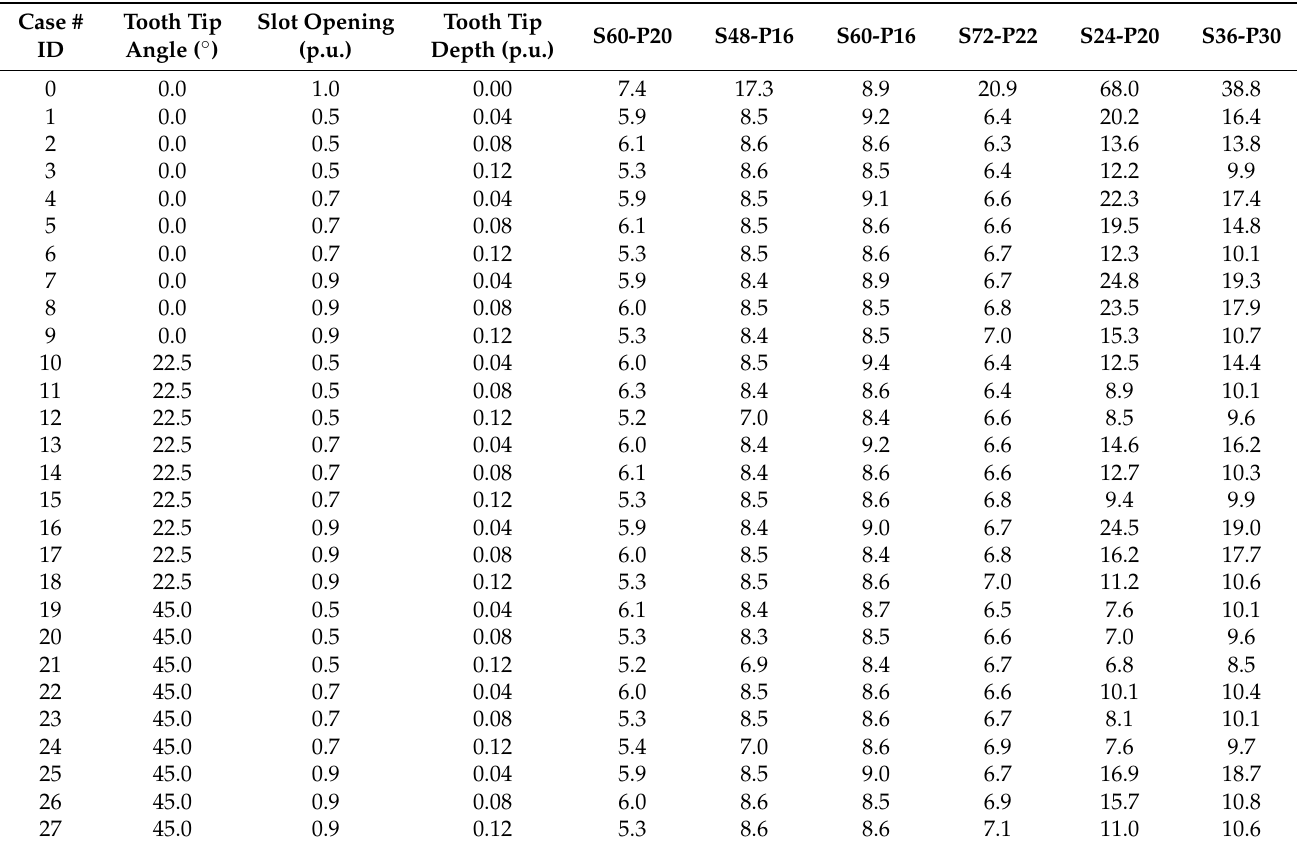
Table 7. AC losses (kW) for the slot opening